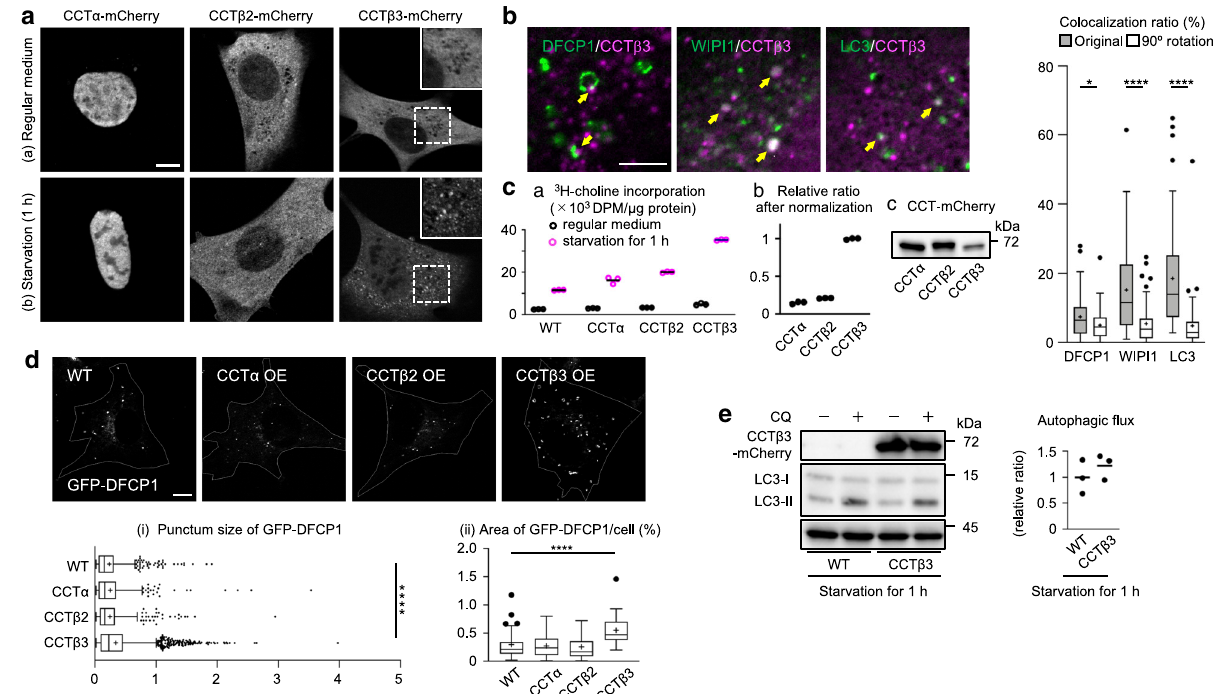
Fig. 3 CCT isoforms in MEFs starved for 1 h. a Distribution of mCherry-tagged CCT isoforms in MEF. (a) Regular medium. (b) Starvation for 1 h. Bar, 10 μ m. b Distribution of CCT β 3-mCherry (magenta) and Atg proteins (green) in MEFs starved for 1 h. Bar, 5 μ m. The colocalization ratios of Atg proteins and CCT β 3-mCherry in the original picture (gray bar) and in the picture after 90° clockwise rotation of the green image (white bar) are shown. Pooled data obtained in three independent experiments ( n = 60); * p = 0.0319, **** p < 0.0001 (two-tailed Mann – Whitney test). c PC synthetic activity. 3 H-choline was added to medium 30 min before harvest. (a) MEFs with or without CCT overexpression cultured in regular medium or starvation medium for 1 h. (b) The result in starvation medium is normalized by the expression level of CCT isoforms, estimated by the CCT-mCherry band intensity in western blotting (c). A representative result of three independent experiments. d The effect of CCT overexpression on GFP-DFCP1 in MEFs starved for 1 h. Bar, 10 μ m. (i)